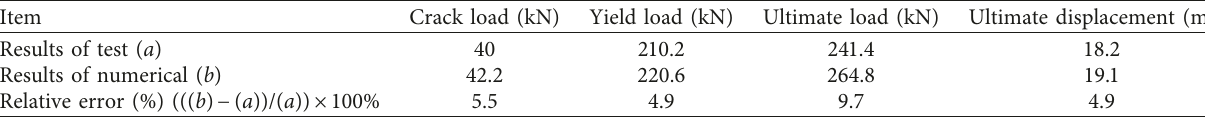
Table 4: Comparison of key point mechanical parameters.